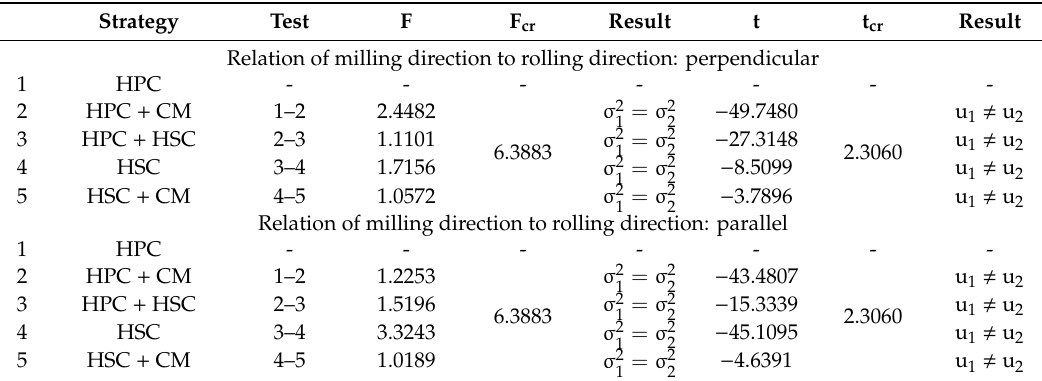
Table 6. Statistical verification of the results of relative deformations ε ( α = 0.05)—without textured surface layer removal.